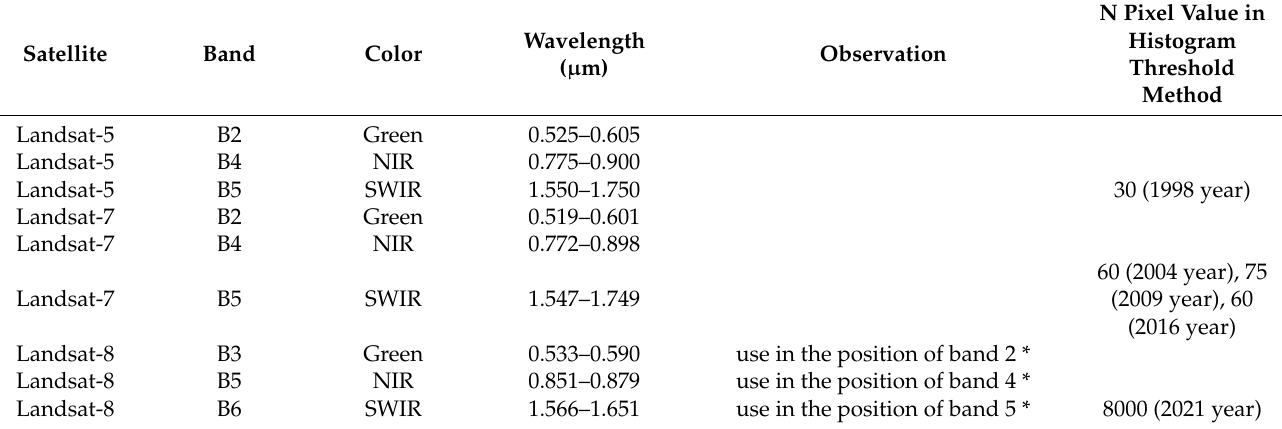
Table 3. Information about the spectral bands and N values used in the Histogram Thresholding Method.